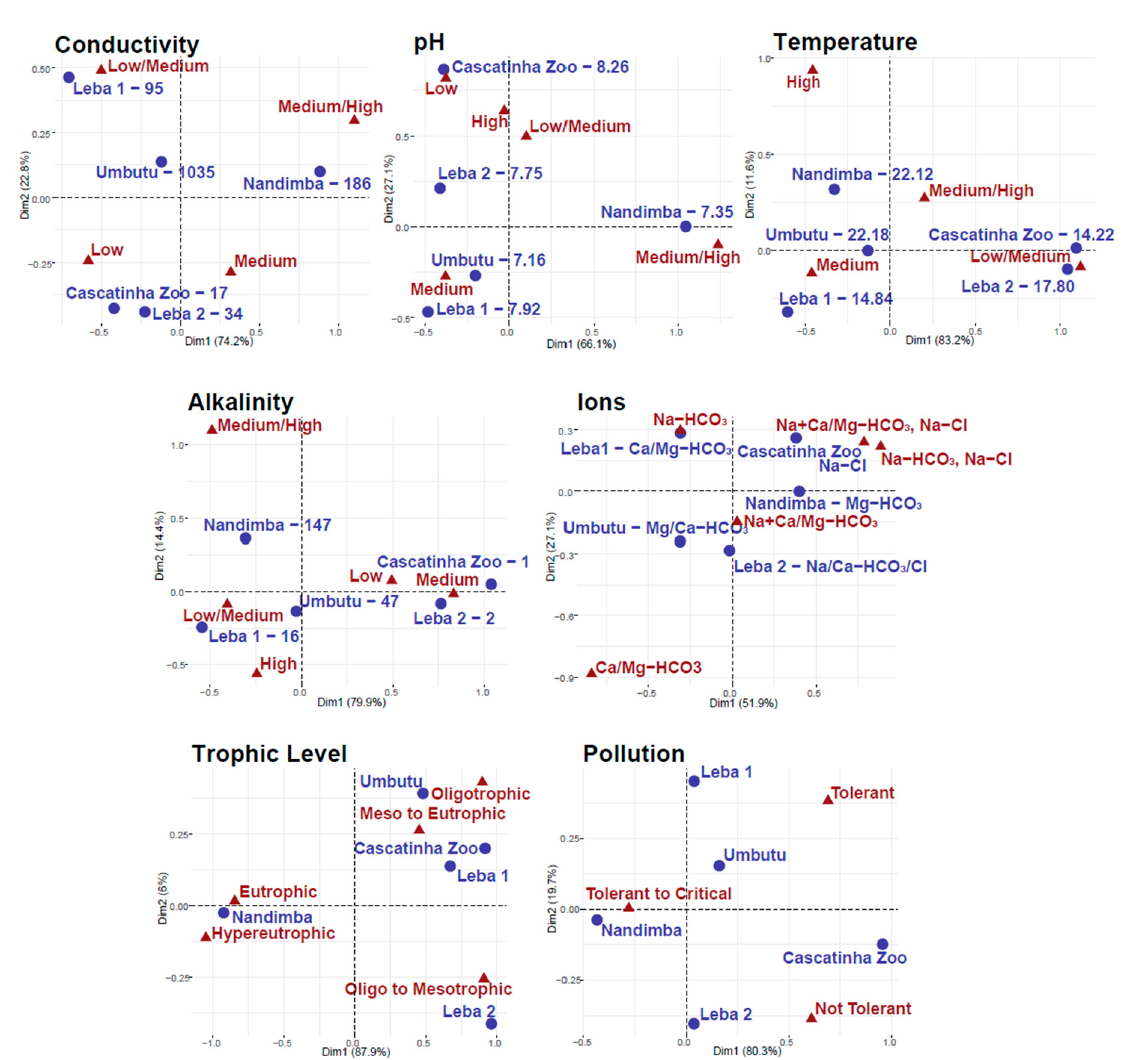
Figure 7. Correspondence analysis of the groupings for the different variables at each site. Chi-square values are only relevant for trophic level and pollution because the rest of the data are not purely categorical and/or were measured in the field. Chi-square values for trophic level and pollution are 2356 and 346, respectively.